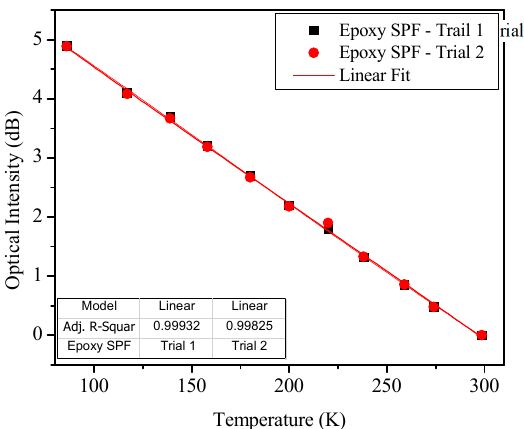
Figure 3. Cryogenic temperature measurements with epoxy-coated SPF sensor. The output is optical intensity variation according to temperature change in 90–298 K.